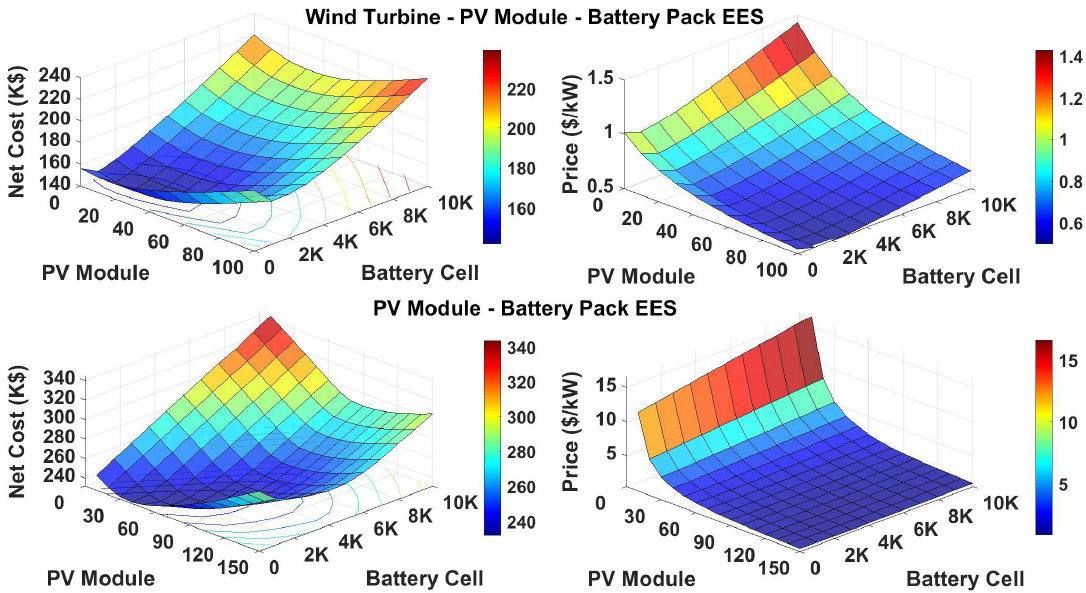
Figure 10. Net cost ( left ) and annualized cost ( right ) of different ESS configurations after 20 years with ( top ) and without ( bottom ) wind